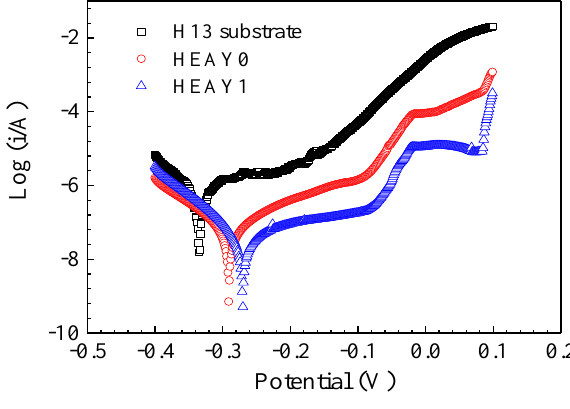
Figure 7. Potential polarization curves for H13 substrate and laser cladding coatings without and with Y 2 O 3 addition. Table 1. The corrosion potential (E corr ) and corrosion current density (I corr ) derived from the potential polarization curves.